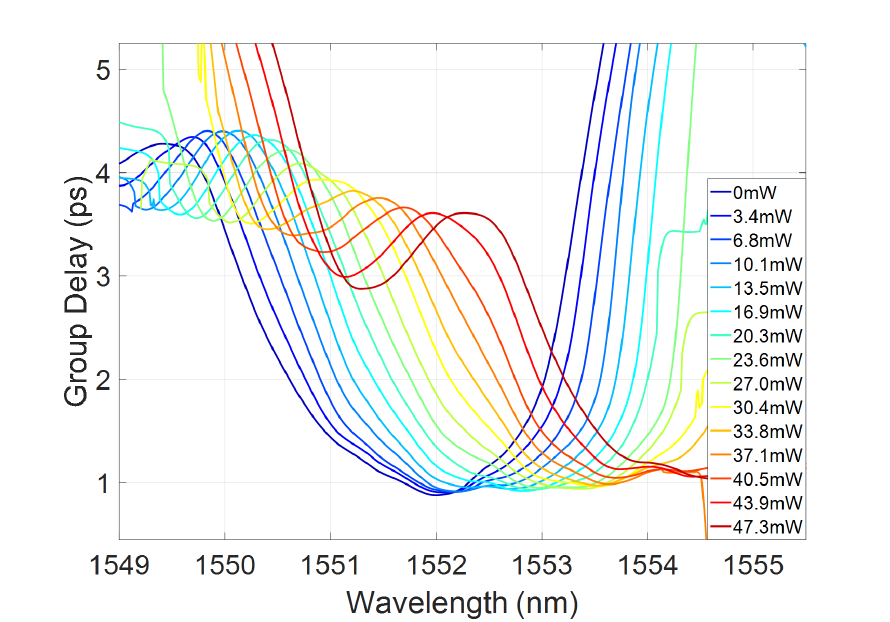
Figure 8. Measured group delay tuning as a function of dissipated power on the